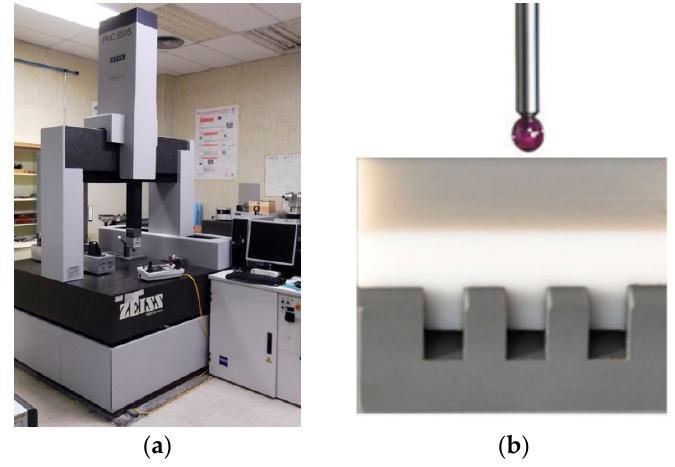
Figure 6. ( a ) CMM Carl Zeiss PMC 850S-CNC used for the calibration of the Step Gauge, the Lego, and the TEF-POM and TEF-PVC workpieces [28]; ( b ) image of the measuring process of the TEF-PVC workpiece with the CMM.